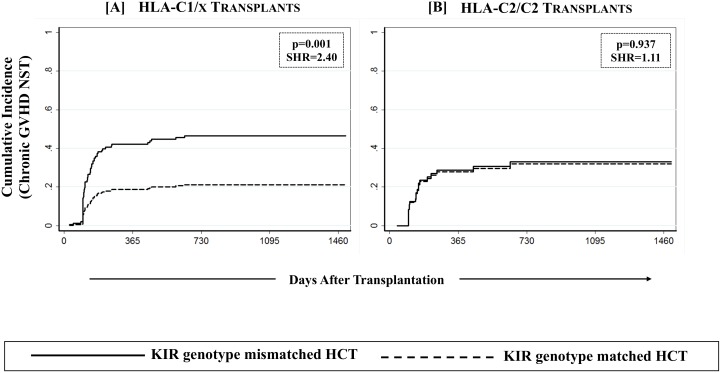
Effect of KIR genotype matched donors on cGVHD among recipients having one or more C1 bearing HLA-C epitopes.Effect of KIR genotype matching was analyzed in a combined group of C1/C1 and C1/C2 recipients (designated as C1/x) as well as in C2/C2 homozygote recipients using a multivariate competing risks regression model.